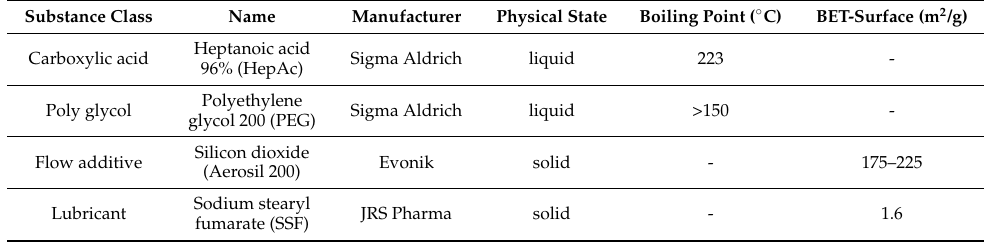
Table 2. Additives with manufacturer